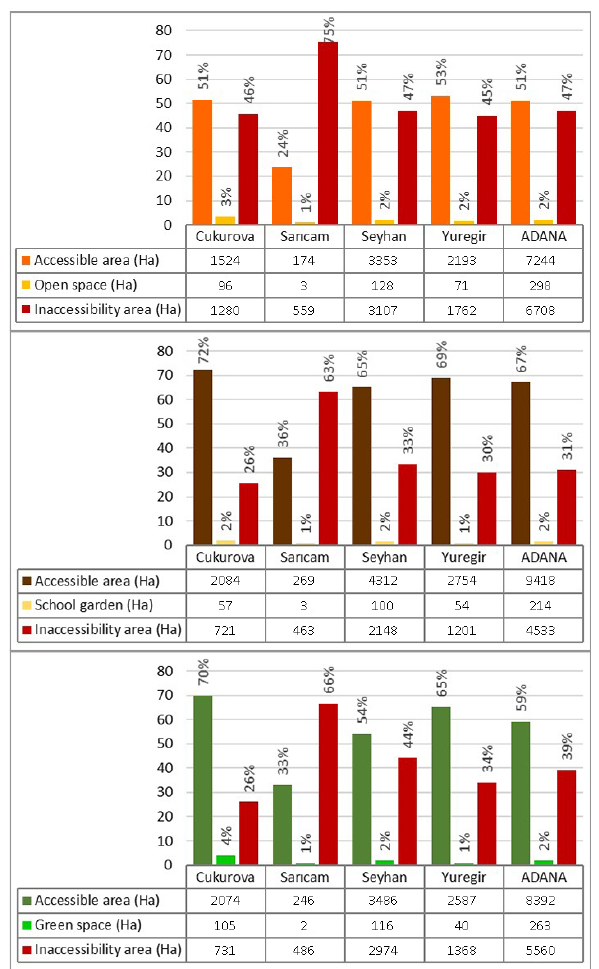
Figure 6: The service area of shelters